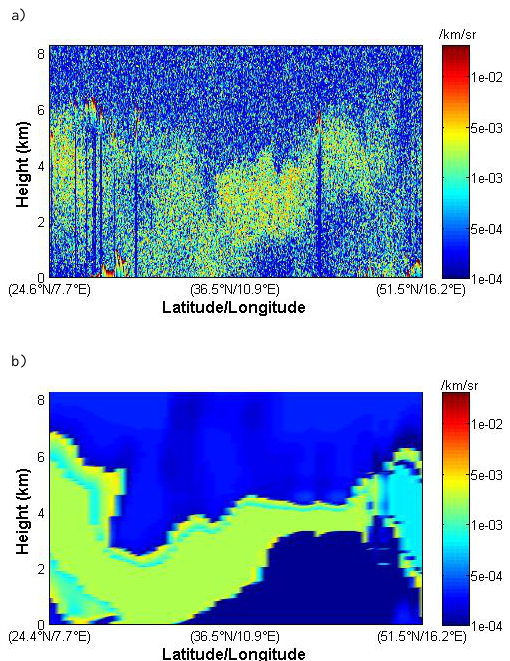
Figure 2. The total attenuated backscatter (km − 1 sr − 1 ) at 532nm from (a) the CALIPSO product and (b) the Meso-NH simulation for the overpass at 01:22–01:27UTC on 28 May 2008. The CALIPSO overpass on 28 May 2008 is indicated by the gray line in Fig. 1a.